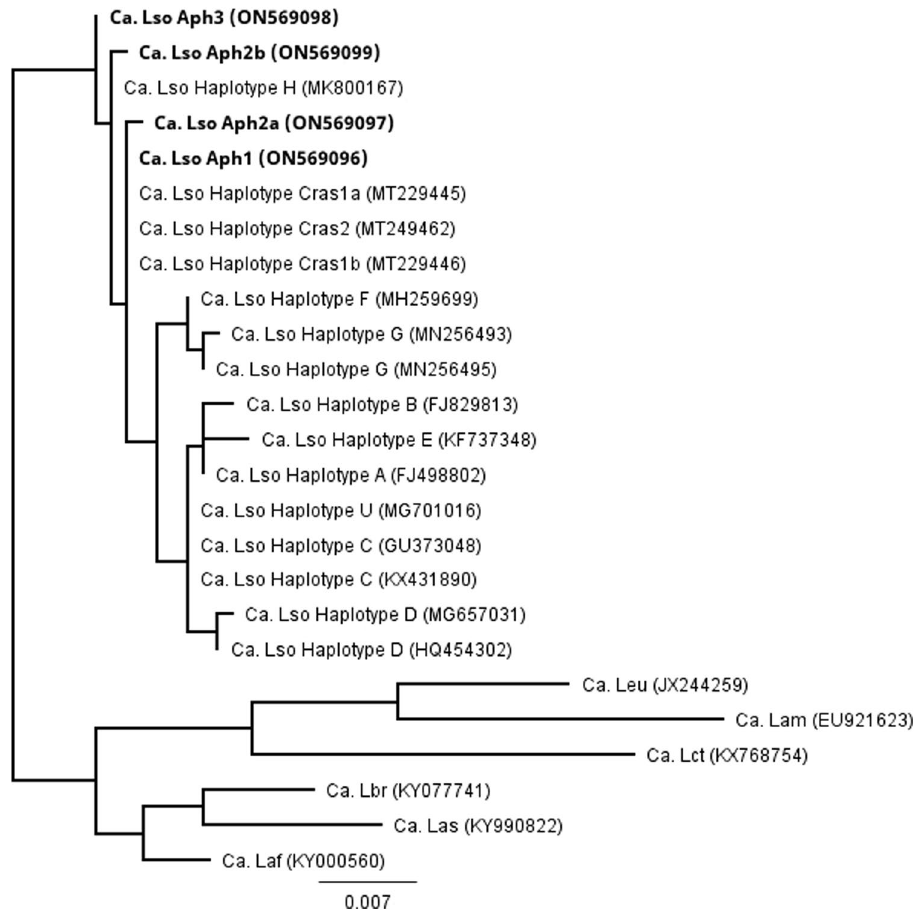
Figure 1. Unrooted phylogenetic tree constructed using a 1,023-basepair region of the 16S ribosomal RNA gene from Ca. Liberibacter species. Abbreviations used were Ca. Lso ( Ca. L. solanacearum) Ca. Laf ( Ca. L. africanus), Ca. Lam ( Ca. L. americanus), Ca. Las ( Ca. L. asiaticus), Ca. Lbr ( Ca. L. brunswickensis), Ca. Lct ( Ca. L. ctenarytaina), and Ca. Leu ( Ca. L. europaeus). GenBank accession numbers are indicated in parentheses and specimens identified in this study are indicated in bold font. Bar length represents substitutions per